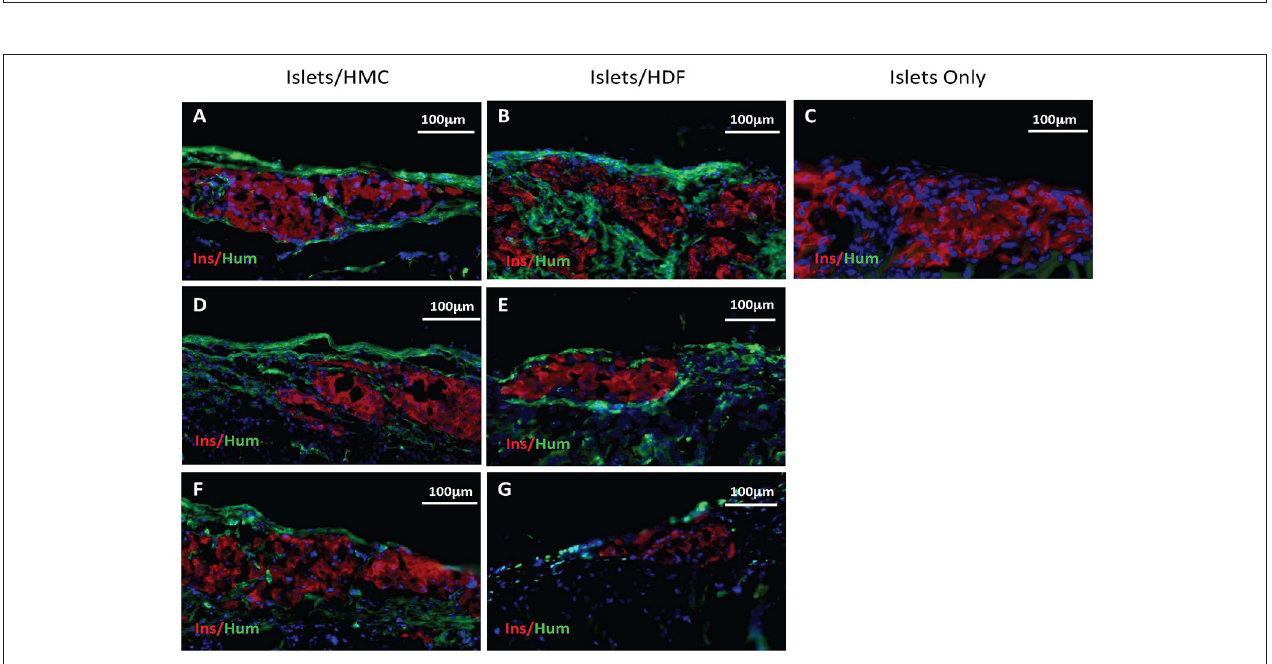
FIGURE 4 | Immunostaining for pro- and anti-inflammatory cytokines. Left panels show representative islets/HMC sections, middle panels show islets/HDF sections, right panels show Islets Only sections. (A–C) Staining for pro-inflammatory Il-1 β at day 7 post-transplant. (D–F) Staining for anti-inflammatory Il-10 at day 3 post-transplant. (Red-cytokine, green-insulin, blue-nuclear DAPI stain) Magnification 200 × .